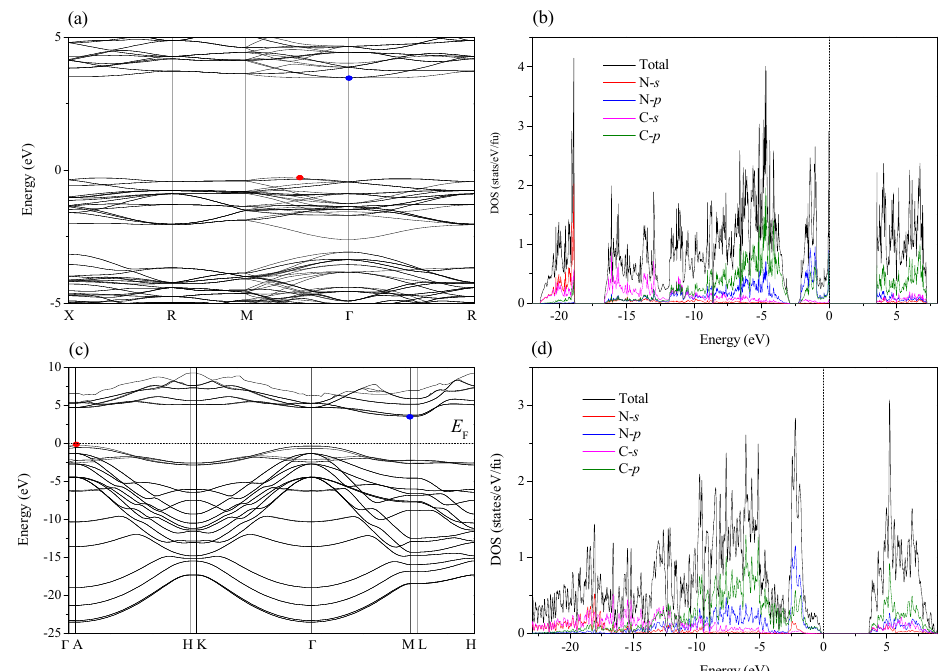
Figure 5. Band structure of c -C 3 N ( a ); DOS of c -C 3 N ( b ); band structure of R 3 m -C 3 N ( c ); and DOS of R 3 m -C 3 N ( d ); the red points represent the valence band maximum (VBM) and the blue points represent the conduction band minimum (CBM); the dotted lines represent the Fermi level. DOS: density of states.